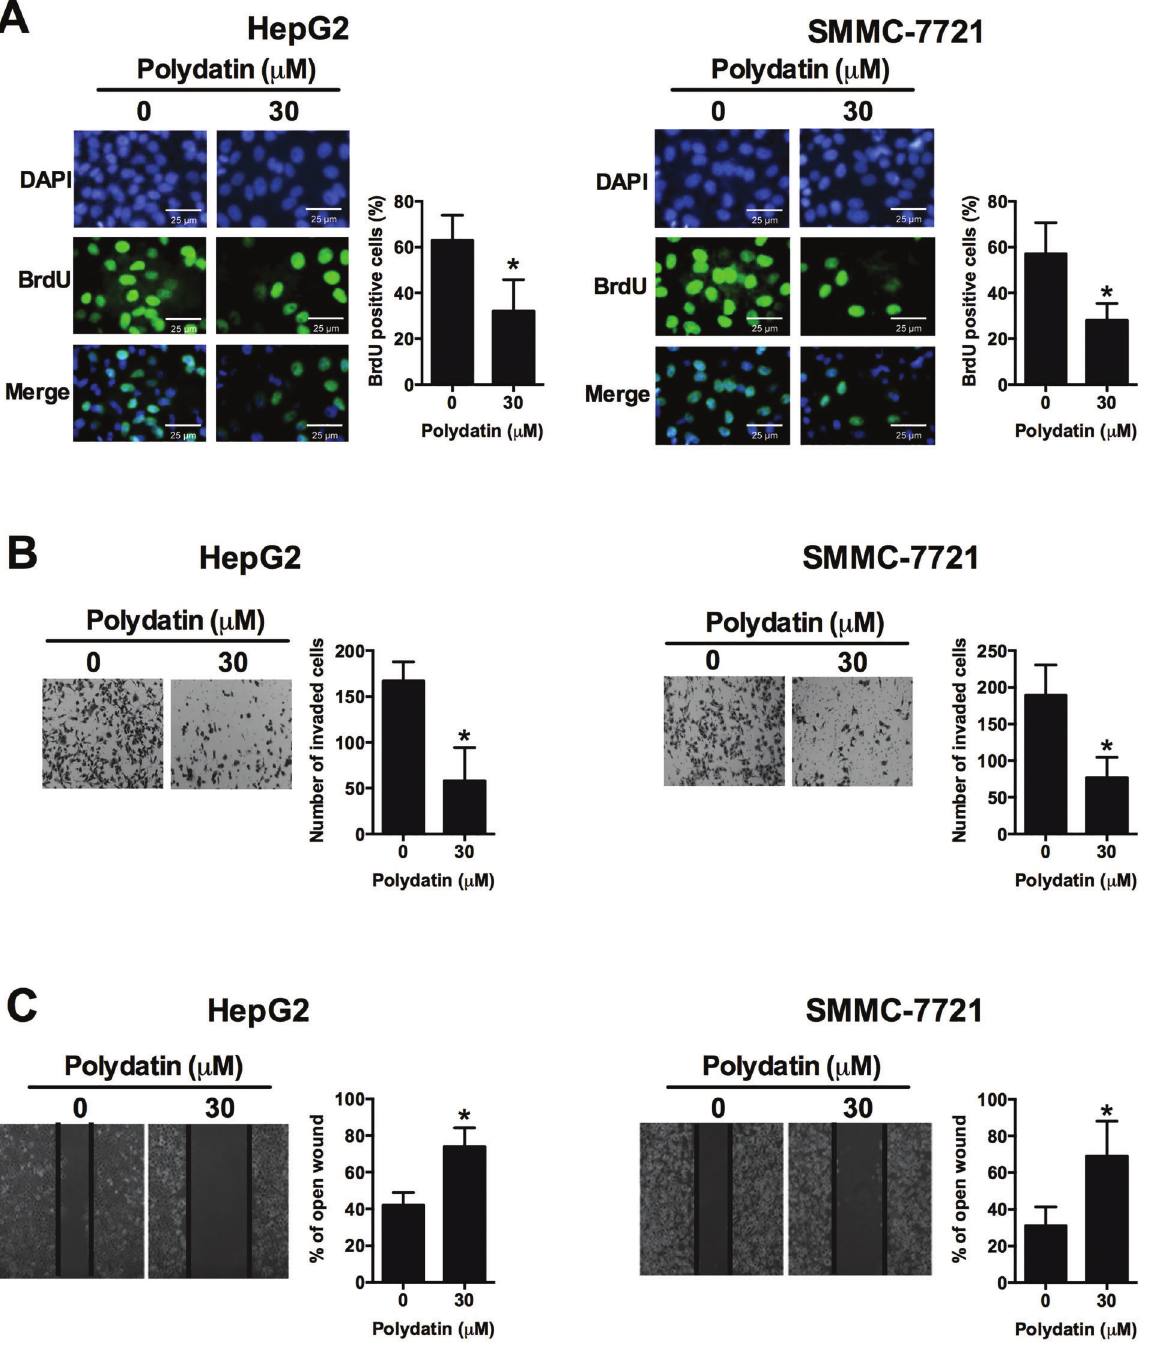
Figure 3. Effects of polydatin-treated liver cancer cell lines HepG2 and SMMC-7721 on A , cell proliferation determined by BrdU assay; B , cell invasion determined by transwell cell invasion assay; C , cell migration determined by wound healing assay. Data are reported as means ± SD. All experiments were repeated 3 times. *P o 0.05 compared to control group (Student ’ s t -test).